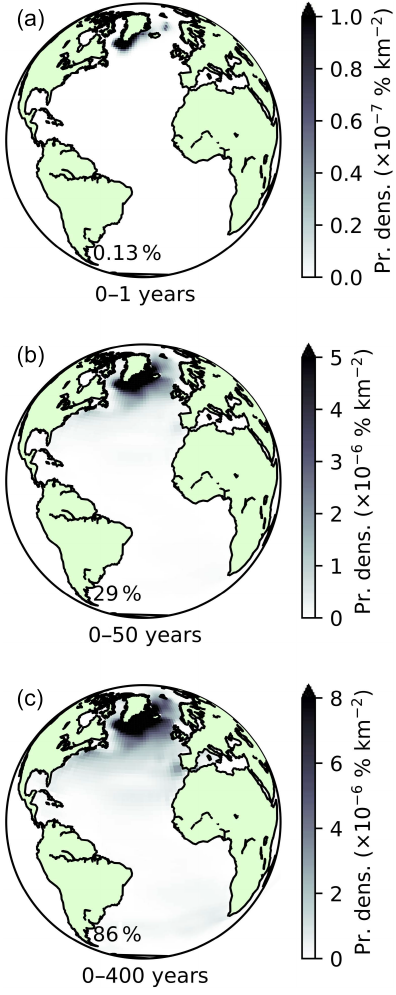
Figure 17. As in Fig. 8 but for NADW and time periods (a) [0,1] years, (b) [0,50] years, and (c) [0,400] years.